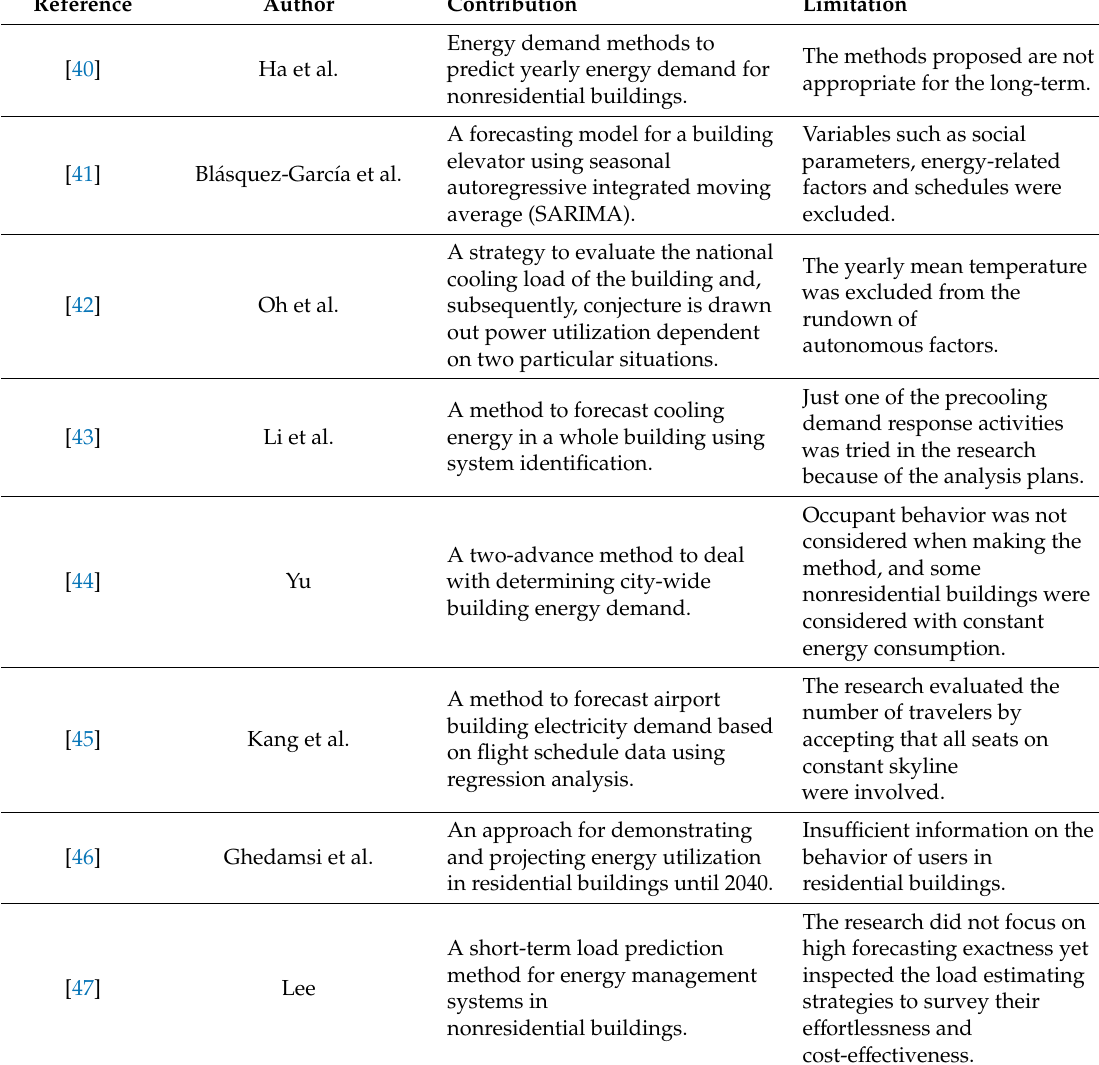
Table 1. Summary of previous research papers and their contributions to physical